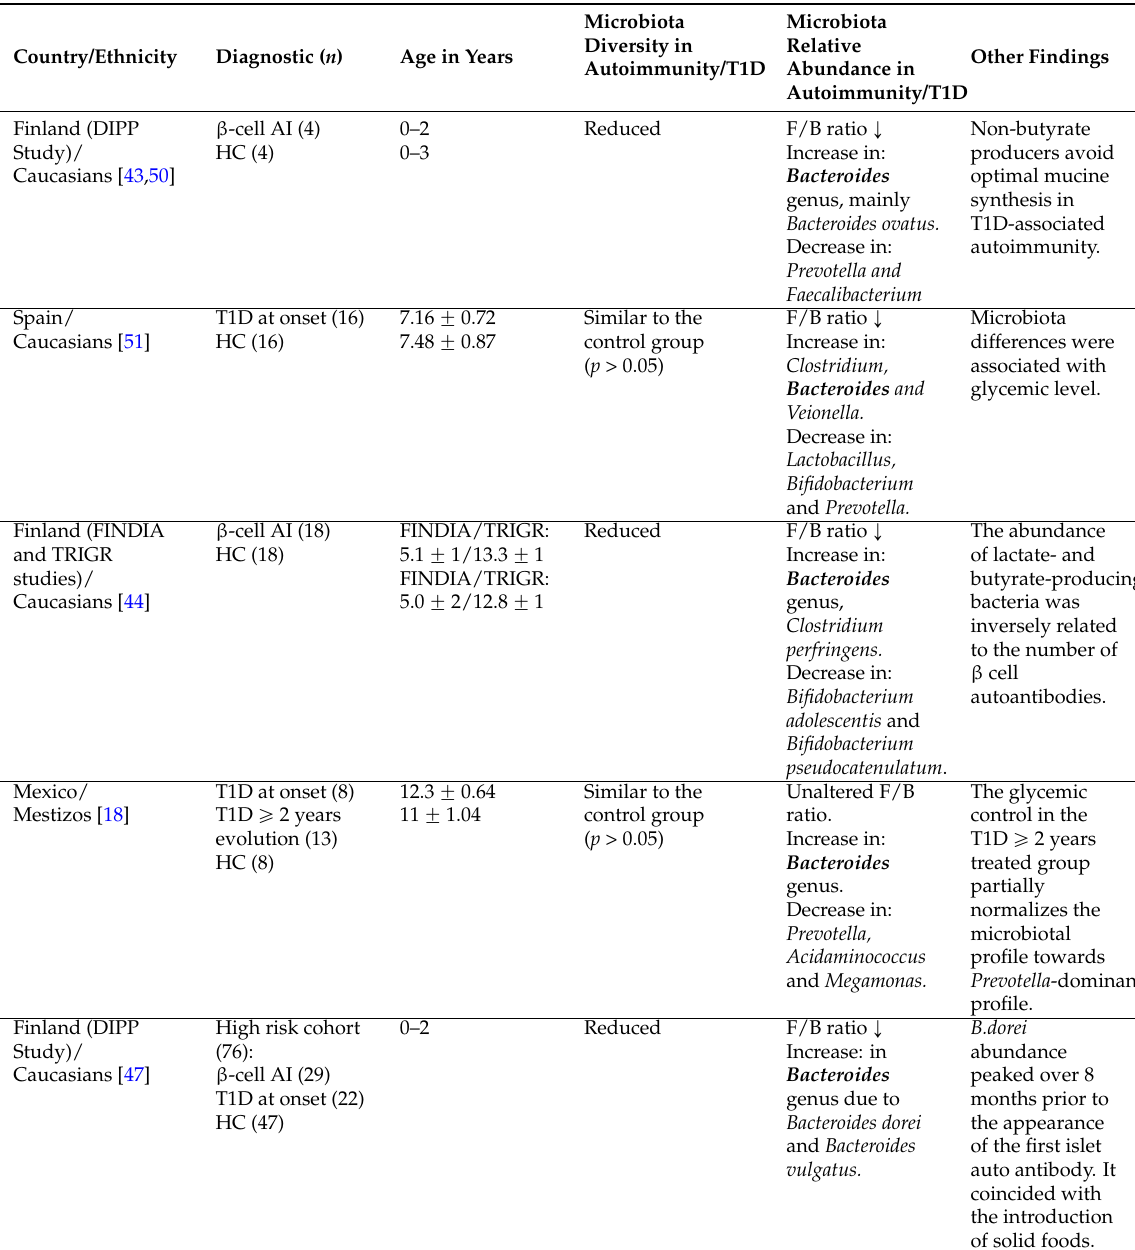
Table 1. Comparison of microbiota composition in humans with autoimmunity and